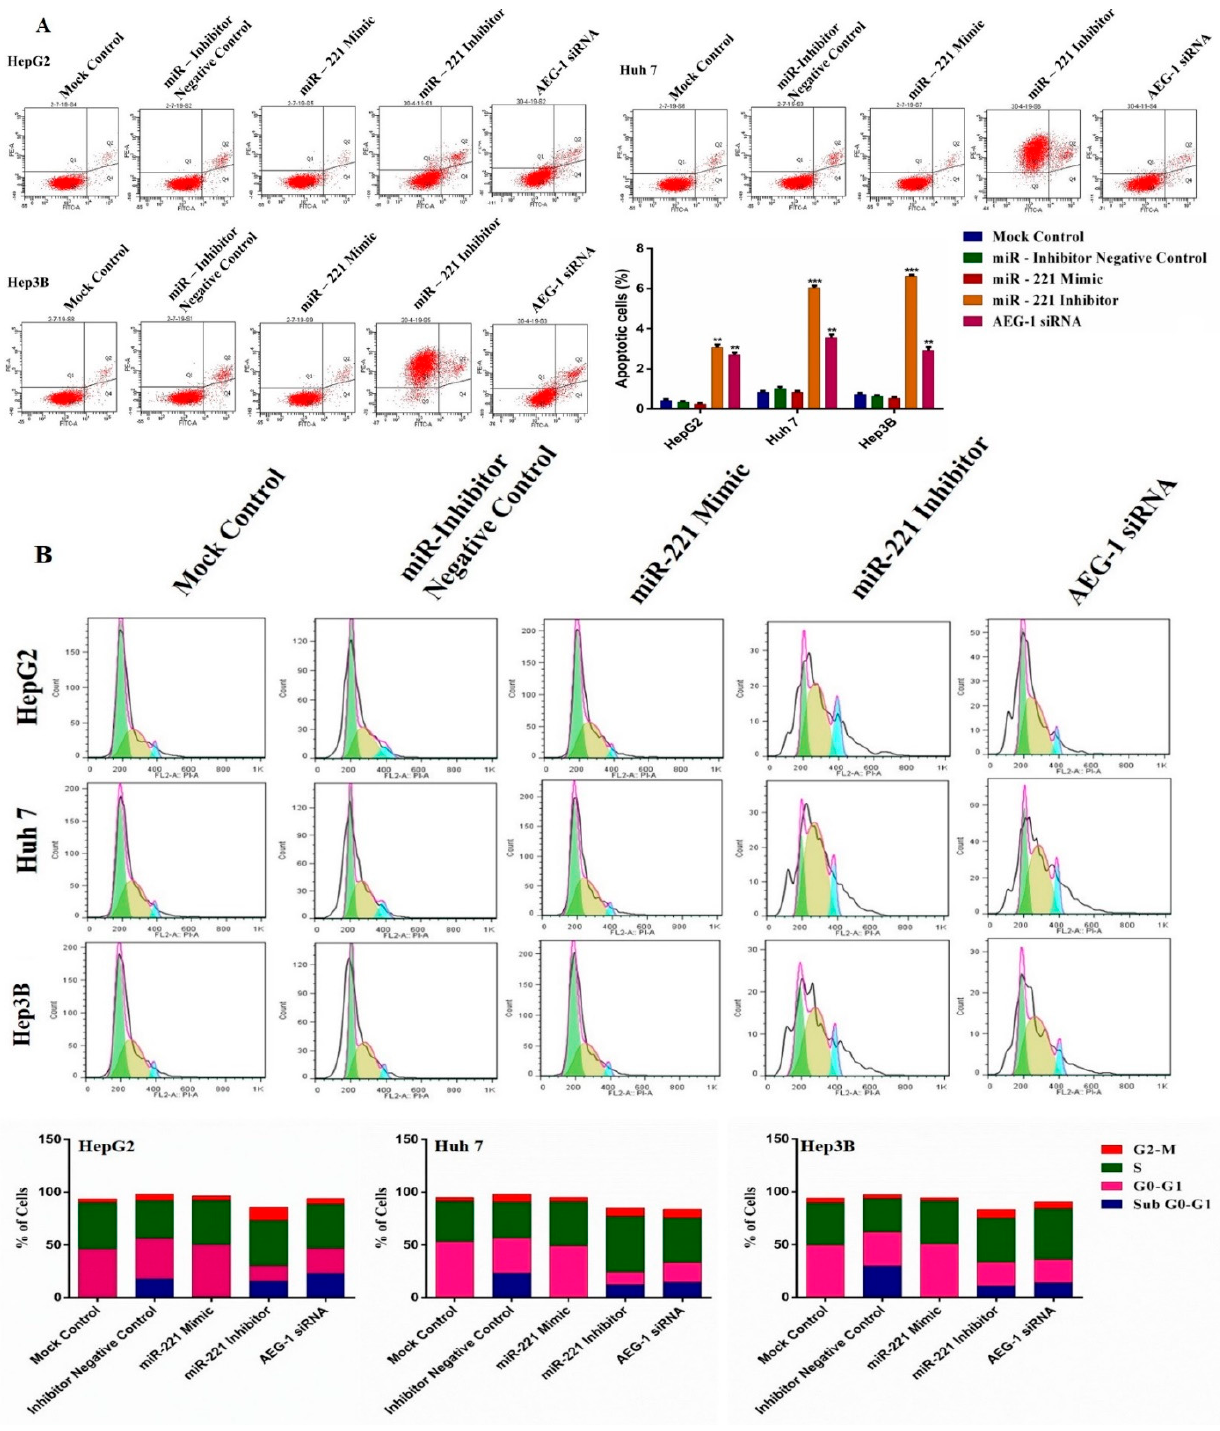
Figure 6. The effects of AEG-1/miR-221 on HCC cell cycle regulation and apoptosis. The effects of AEG-1/miR-221 on apoptosis ( A ) and cell cycle ( B ) analyzed in the miR-221 mimic-, and miR-221 inhibitor-, AEG-1 siRNA-, and their corresponding control-transfected HCC cells in vitro by flow cytometry analysis. Error bars presented as the mean ± s.d. and p -values represented as ** p < 0.01, *** p < 0.001 compared to the corresponding controls.